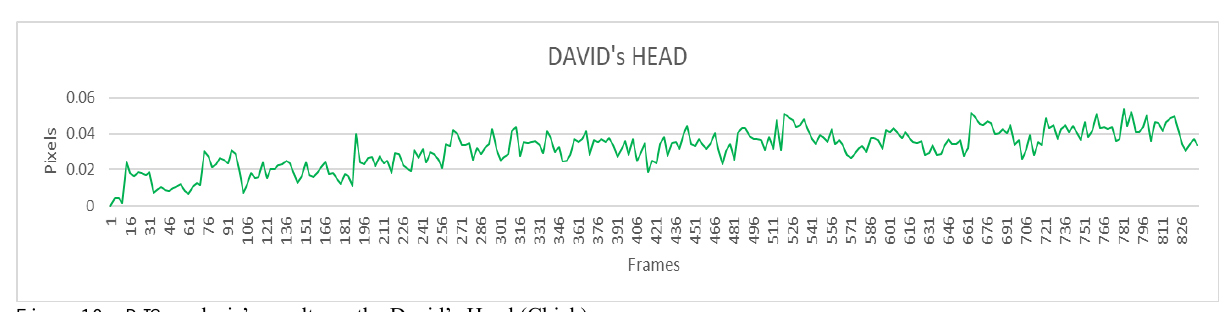
Figure 9 – DIC analysis’s results on Scanner body .